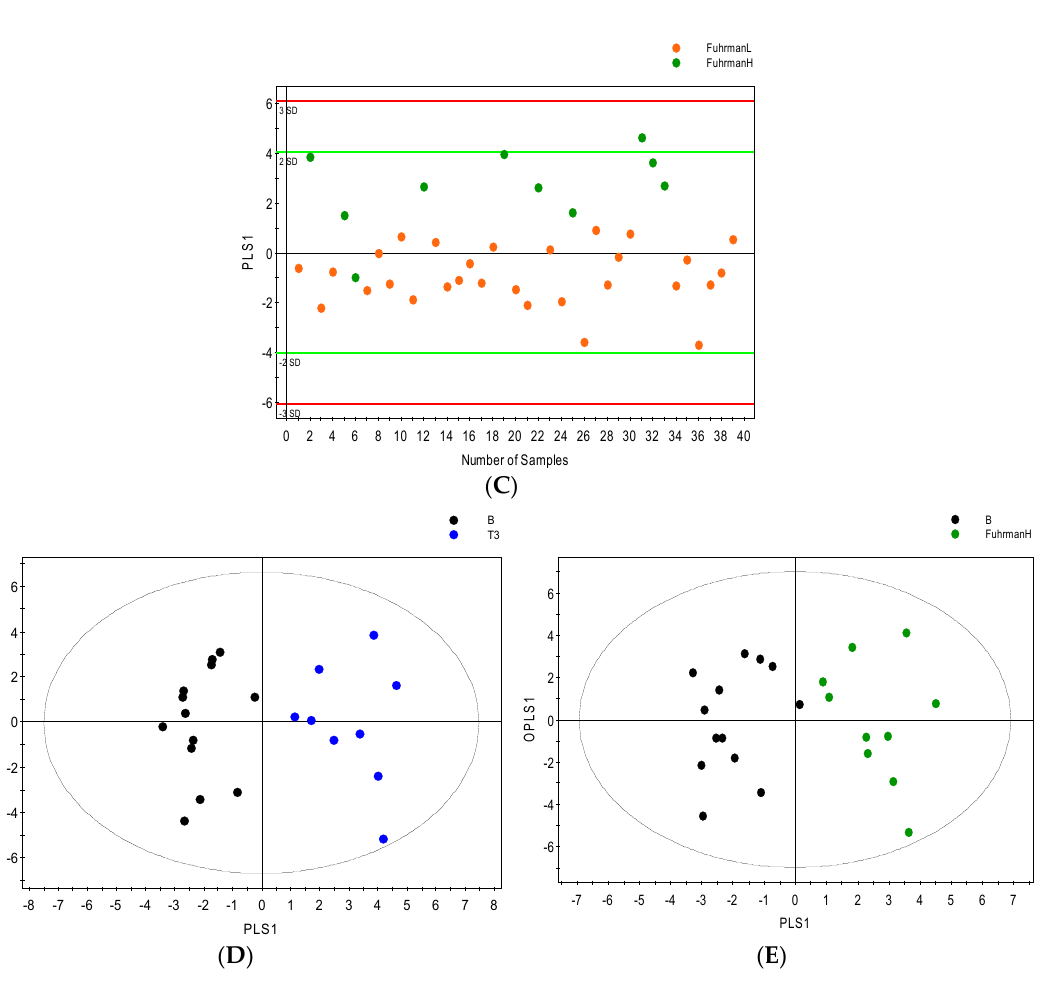
Figure 4. GCMS orthogonal partial least squares discriminant analysis (OPLS-DA) models distinguishing between benign and cancer cases. OPLS-DA score scatter plots showing separation in the serum metabolic profile of ( A ) stage 1 versus stage 3 cancer cases; ( B ) benign versus stage 3 cancer cases; ( C ) low grade (FuhrmanL–stages 1 and 2) versus High grade (FuhrmanH–stages 3 and 4) cancer along their orthogonal partial least squares (OPLS1) and partial least squares components (PLS1); ( D ) OPLS-DA score scatter plots depicting the urine metabolic signature distinguishing benign subjects from stage 3; and ( E ) benign cases from high grade (FuhrmanH–stages 3 and 4), (ellipsoid: Hotelling’s T2, 95% confidence interval).